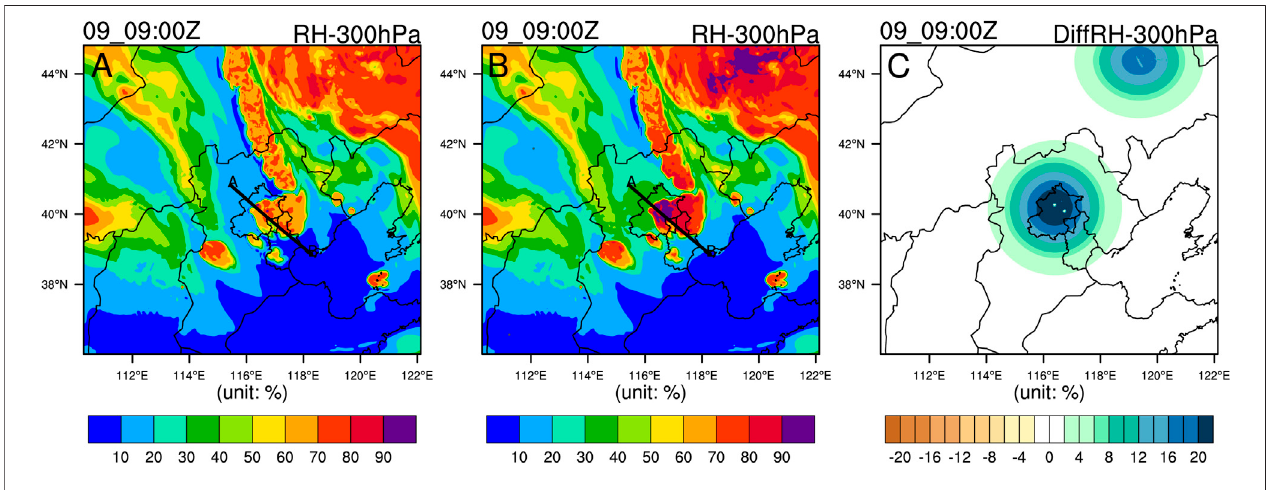
FIGURE 8 | Comparison of relative humidity (unit: %) at 300 hPa at 0900 UTC 9 August between (A) control experiment, (B) assimilation experiment, and (C) differences between control experiment and assimilation experiment. The solid lines represent cross-section in Figures 9A,B .